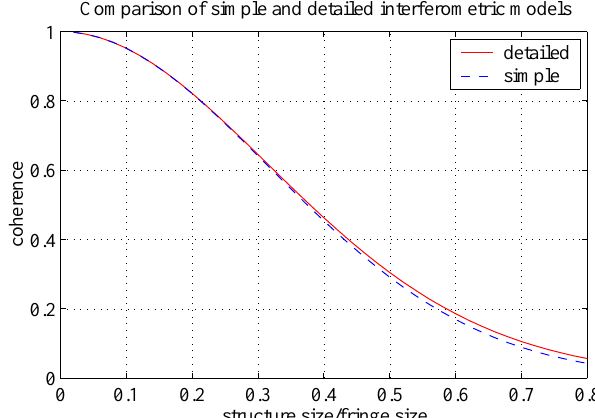
Fig. 2. Comparison of coherence computed using point antennas (dashed line) and Gaussian antennas, Eq. (12) (solid line), where the beam widths and separation of the EISCAT Svalbard Radar an- tennas have been used. The fringe size ( = 1 / 2 A ) corresponds to 234m at 100km